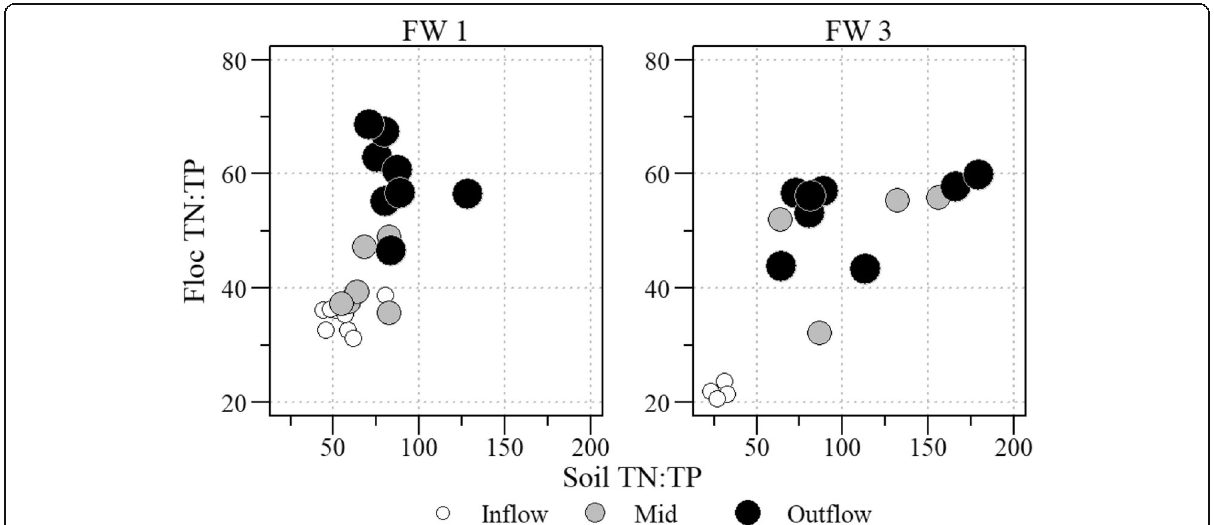
Fig. 6 Comparison of floc and soil TN:TP molar ratio with location along the flow-way identified by size of point (i.e., larger point further down flow path) and distance categories